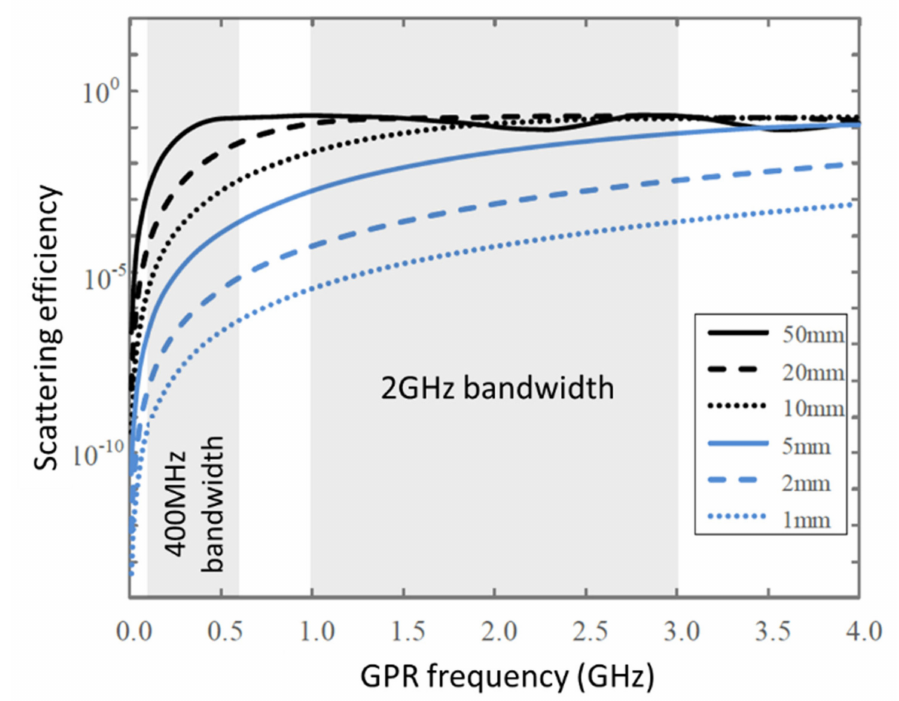
Figure 7. Scattering efficiency for different sizes of voids in ballast layer [86].